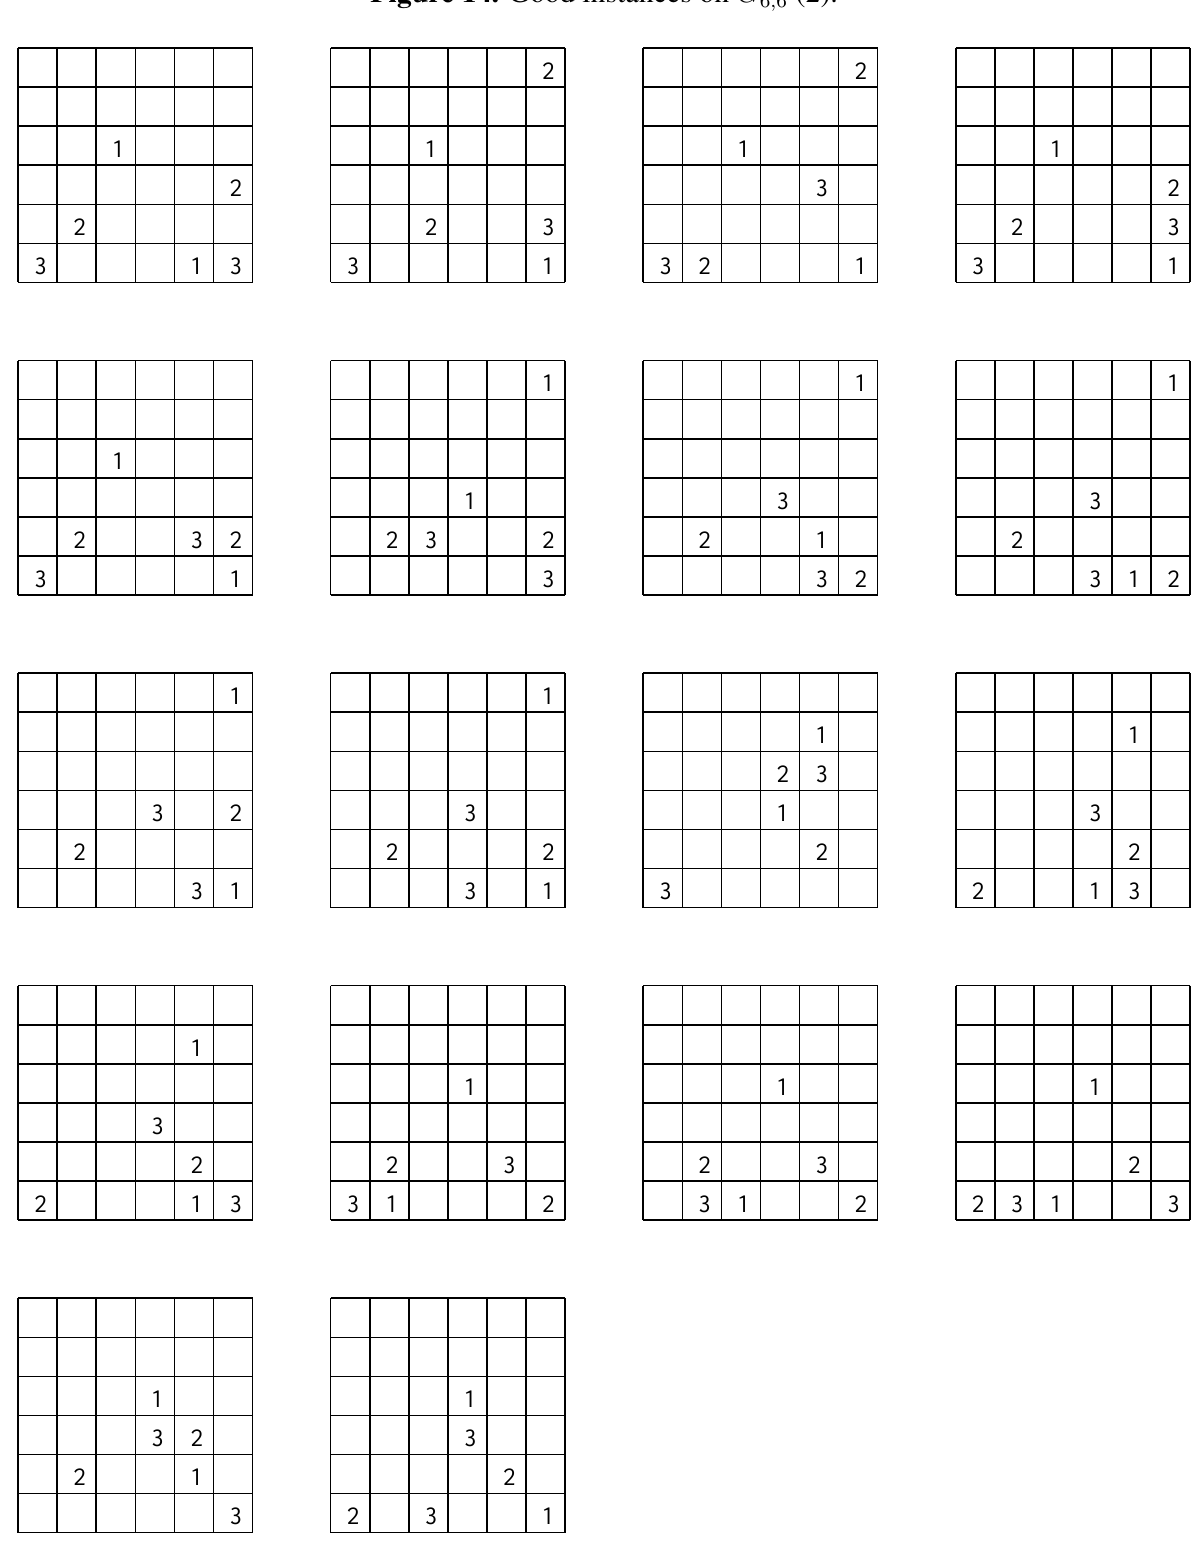
Figure 14. Good instances on G